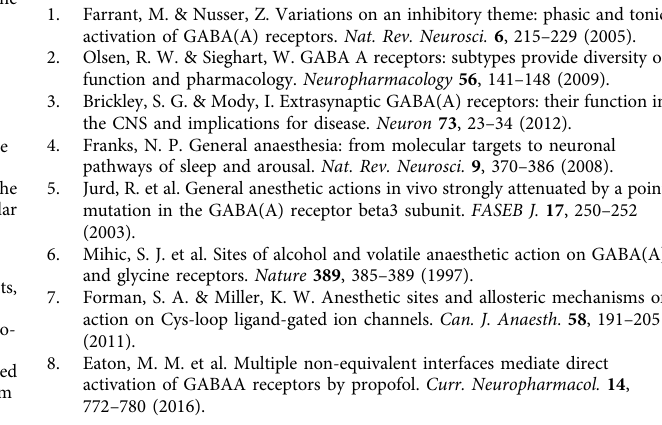
Table 1. The molecular replacement method was used for the initial structure determination. The ECD of ELIC (PDB code: 4Z90) 63 and the TMD of β 3GABA A R (PDB code: 4COF) 13 were used as the isolated search ensembles for the molecular replacement solution by PHASER 64 . The TMD of the initial solution was then mutated to α 1GABA A R and used as the new search model for molecular replacement. The results clearly indicated two pentamers in the crystallographic asymmetric unit. This initial model was then re fi ned in both the BUSTER 65 and Phenix 66 programs. Non-crystallographic symmetry (NCS) restraints were